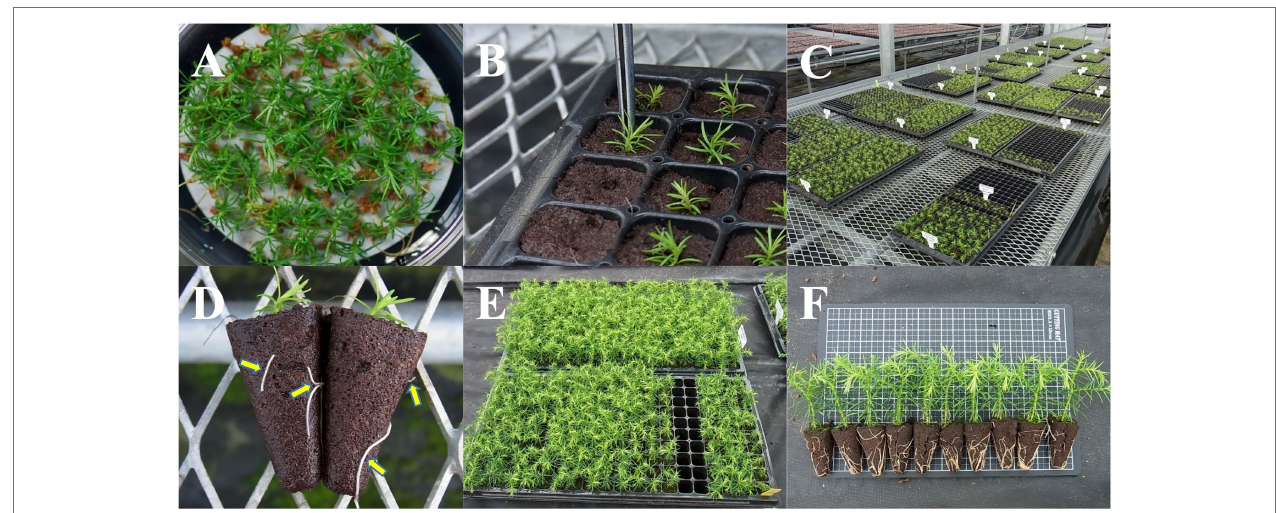
FIGURE 4 | Ex vitro acclimatization and growth of acclimatized pollen-free sugi ( C. japonica ) somatic plants. (A) In vitro regenerated somatic plantlets. (B) Transfer of somatic plantlets into plant plugs. (C) Plug plants kept inside the greenhouse under mist watering control. (D) Acclimatized somatic plants showing roots (yellow arrows) emerging from the plugs. (E,F) Growth and appearance of somatic plants approximately 3 months after their transfer into plant plugs. Size of plant plugs: 23 × 23 × 38 mm.